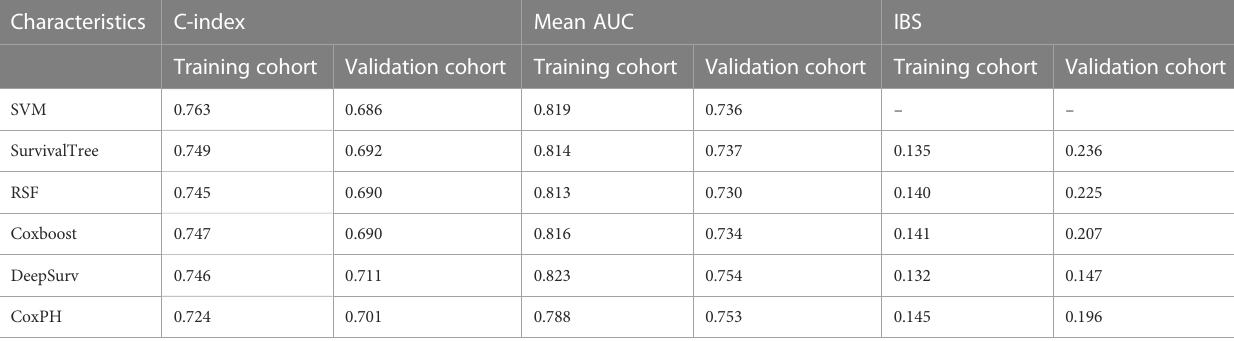
TABLE 4 Comparison of the bootstrapped C-indexes, mean AUC, and IBS of different models for dCCA patients in the training cohort and the validation cohort.